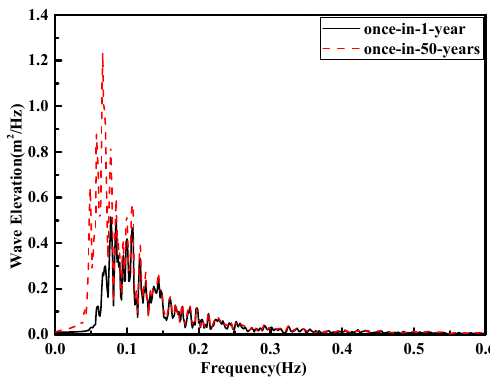
Figure 14. Power spectra of wave elevation.